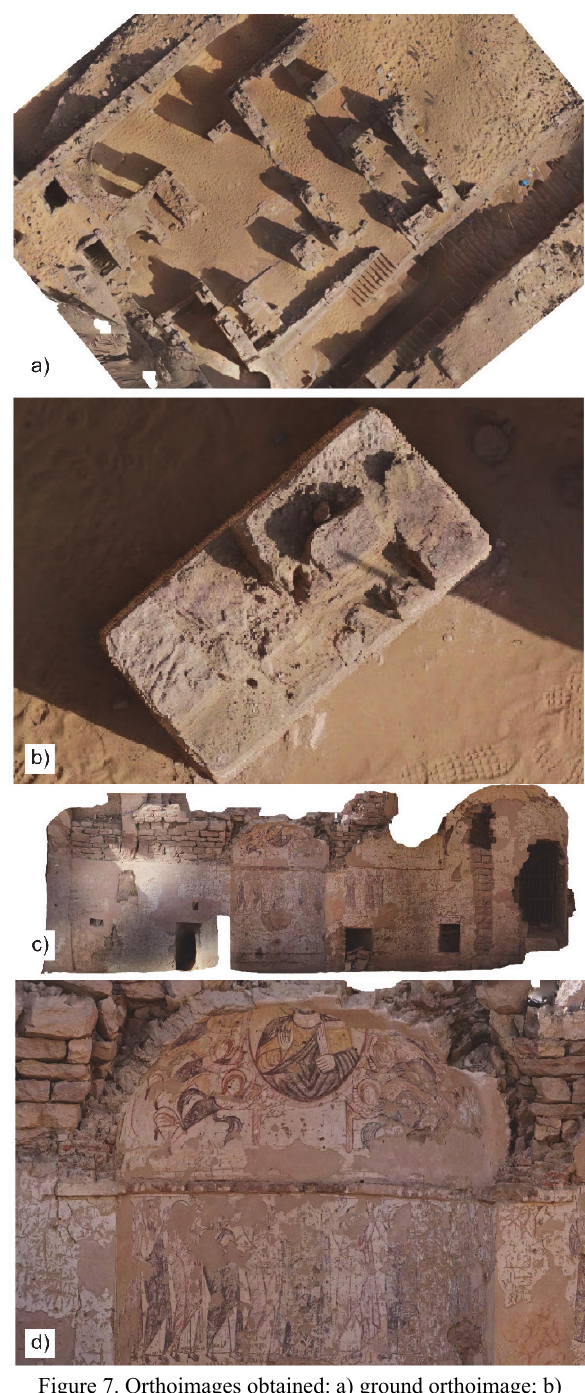
Figure 7. Orthoimages obtained: a) ground orthoimage; b) detailed view of ground orthoimage; c) SW wall; d) detailed view of SW wall